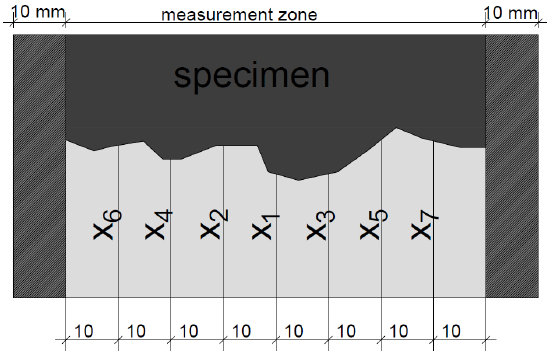
Figure 4. Principle of chloride penetration depth measurement.